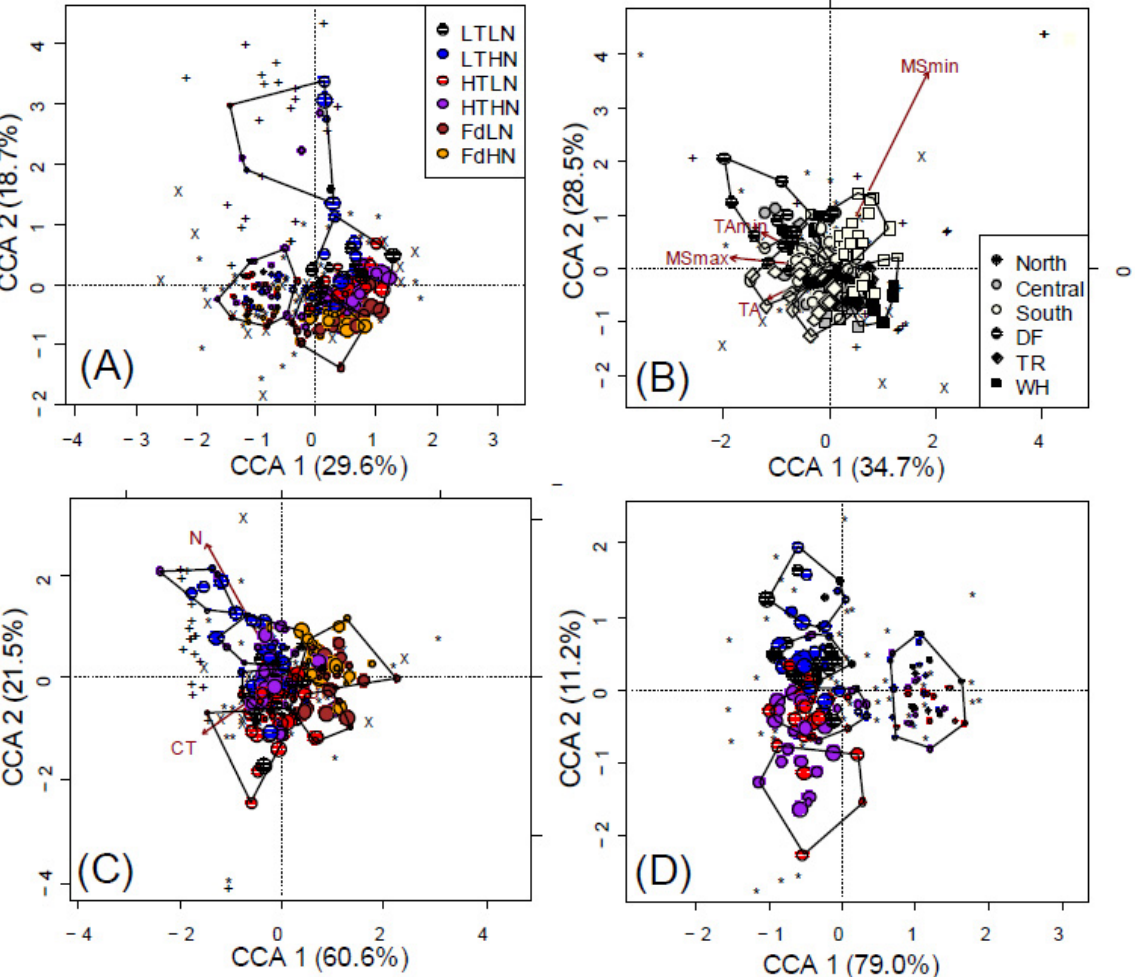
Figure 1. Constrained correspondence analysis showing the effects of ( A ) time, litter chemistry, climate and space (14.8% of total inertia) on microbial composition of fungi (*), NifH (+) and AmoA (X) communities. Partially constrained correspondence analysis ( B ) removing all effects except climate (2.75% of total inertia) or ( C ) litter chemistry (3.2% of total inertia) is also shown. The effects of both time and litter chemistry ( D ) on only fungal community composition in poplar litter (7.6% of total inertia). Point size decreases with time in panels A, C and D. Polygons represent k- means clustering based on CCAs 1 and 2.